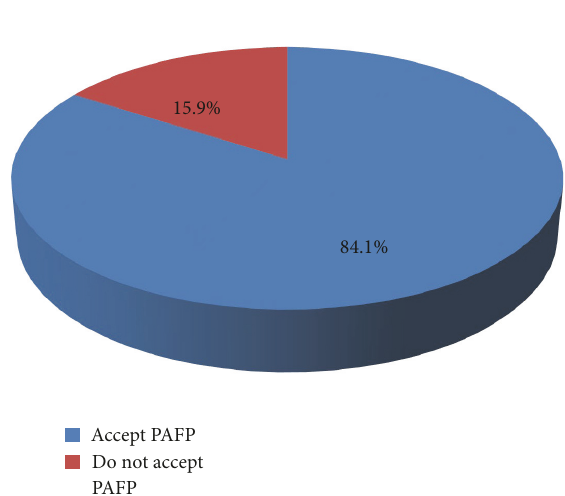
Figure 3: Acceptance of postabortion family planning among abortion service clients in Dessie, Amhara, Ethiopia,